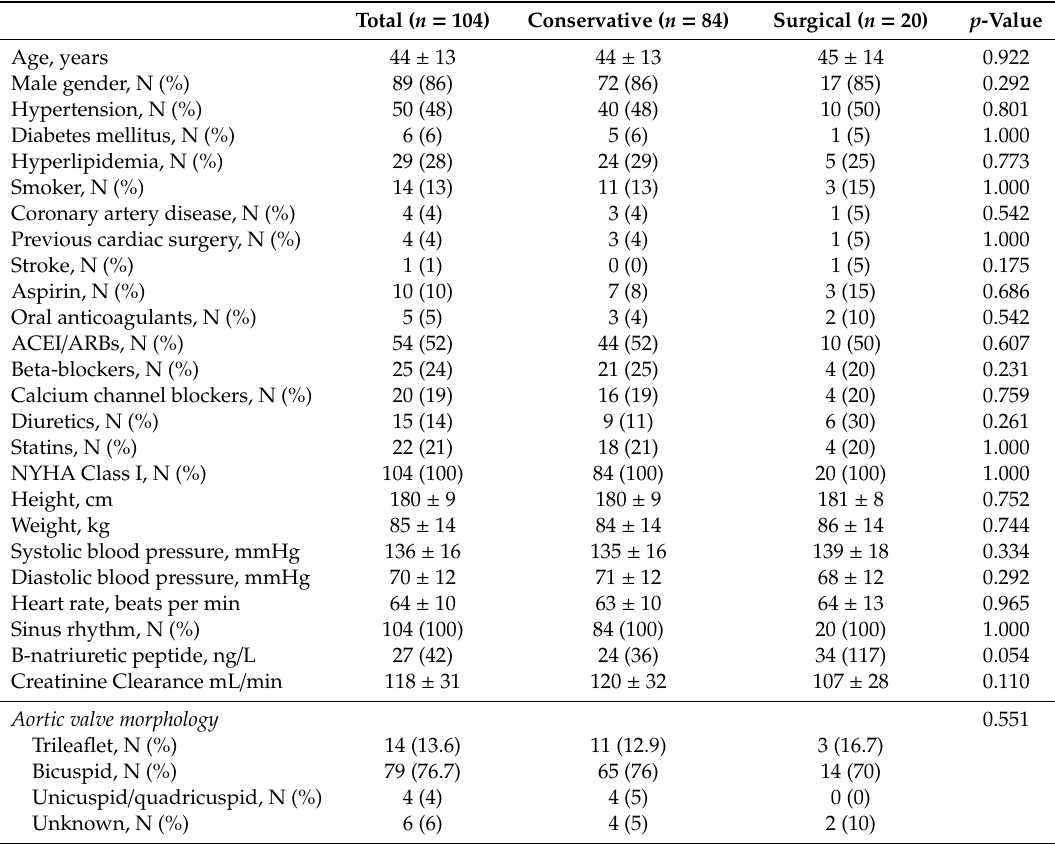
Table 1. Baseline clinical